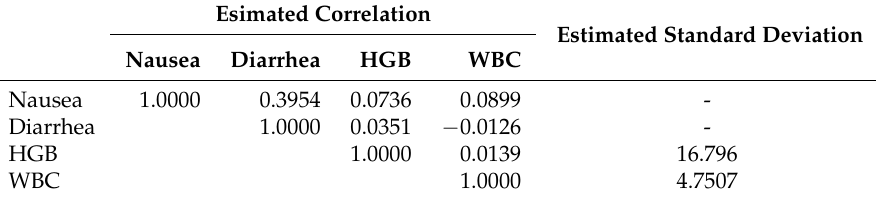
Table 4. Estimation Results II: the estimated parameters contain second moments of each